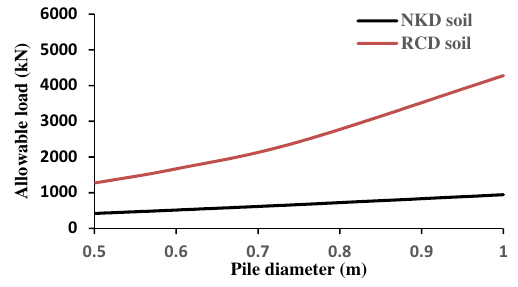
Fig. 4 Allowable load carrying capacity (P diameters in NKD and RCD